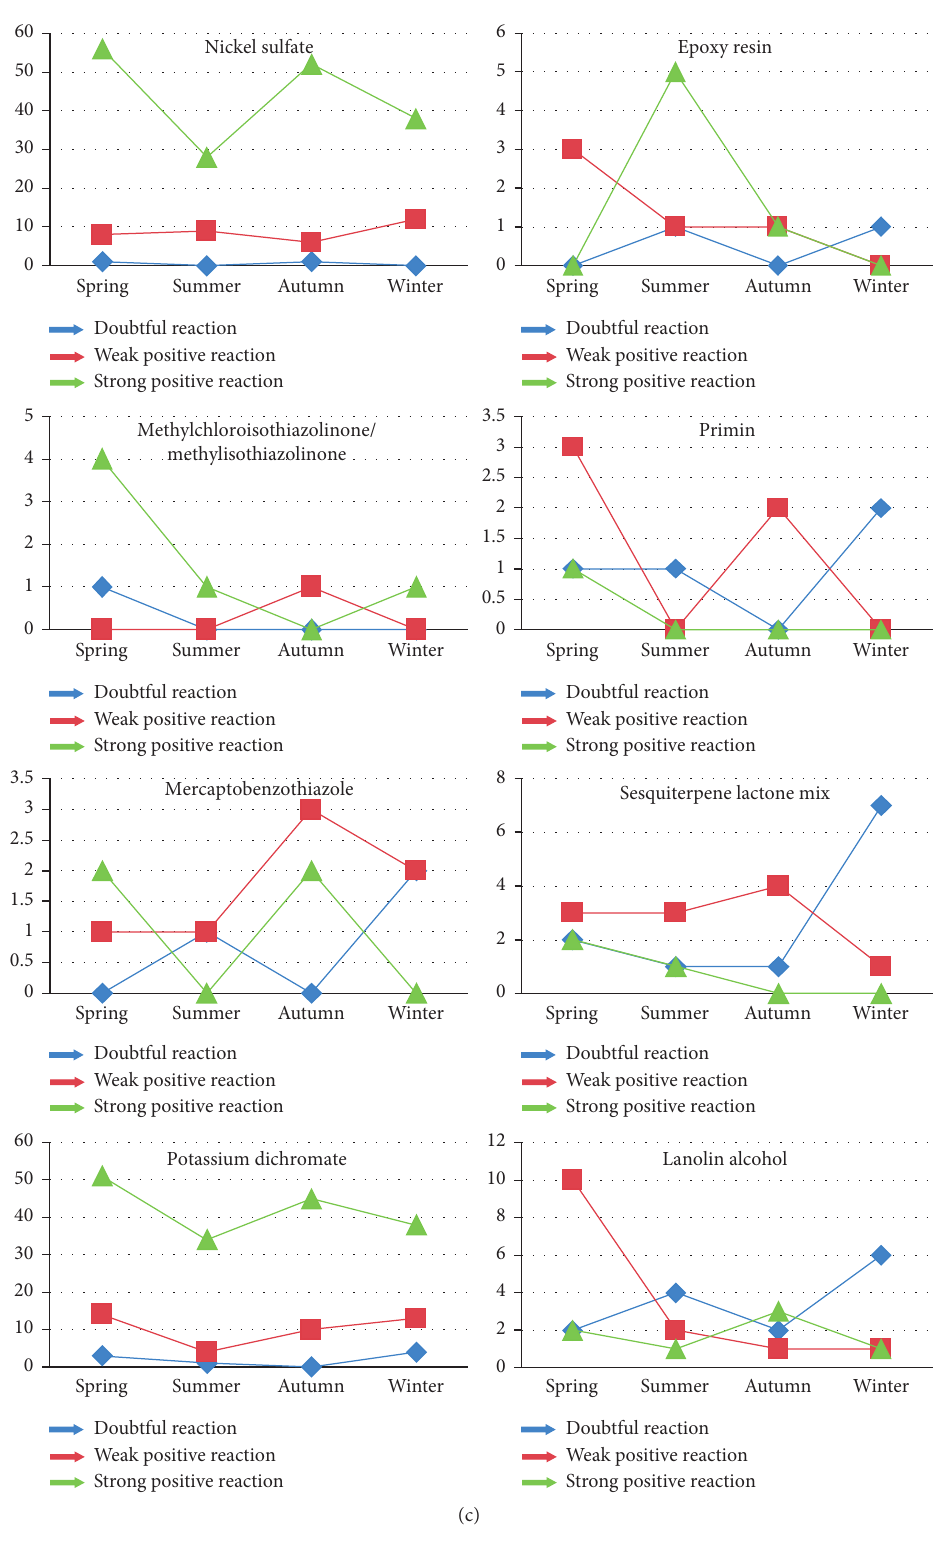
Figure 2: Patch tests results of different allergens according to the